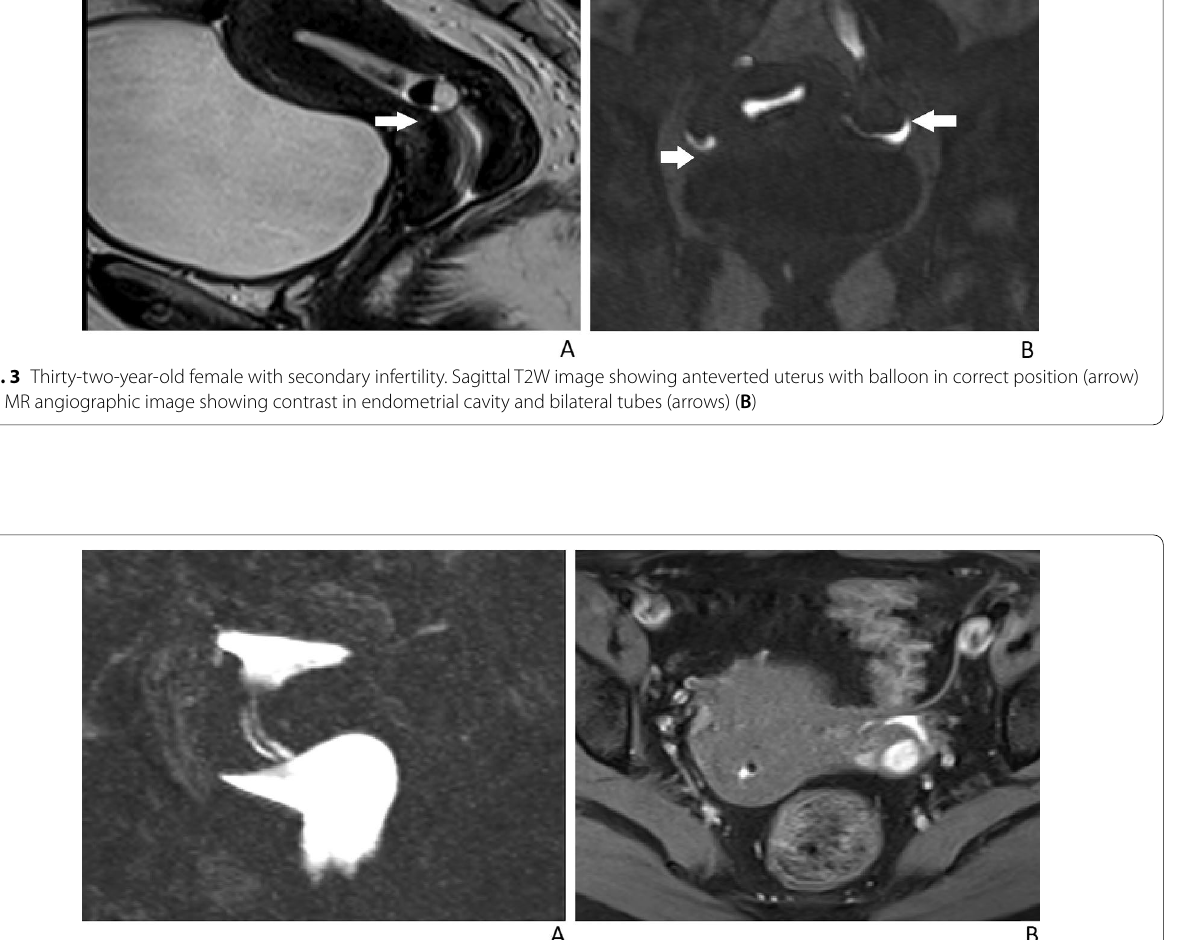
Fig. 4 Thirty-year-old female with primary infertility.MR angiographic image showing dilute gadodiamide in endometrial canal and thin rim of contrast in left fallopian tube. Reflux of contrast material in vaginal lumen due to tubal occlusion ( A ). Minimal amount of left tubal spill seen. No spill on right side ( B